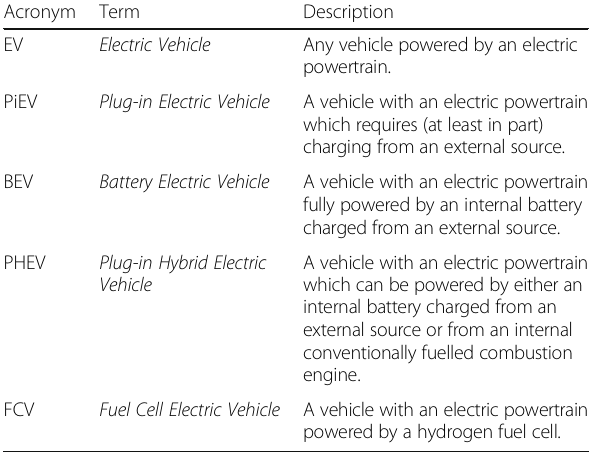
Table 1 Key acronyms for powertrains used in this